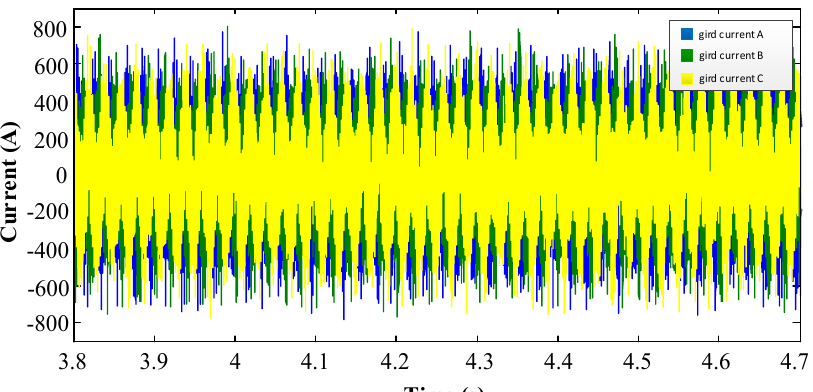
L = 3.7 mH). = 3.7 mH). Figure 19. The simulated three-phase grid output currents of GSC in the stable case ( l